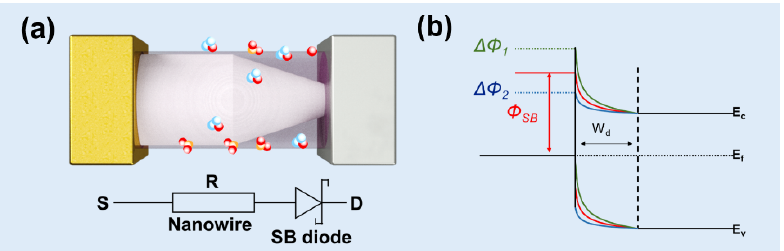
Figure 23. A schematic diagram of Schottky-contacted sensors: ( a ) structure of a Schottky-contacted sensor; and ( b ) change of Schottky barrier height and depletion region under the external stimula- tion.